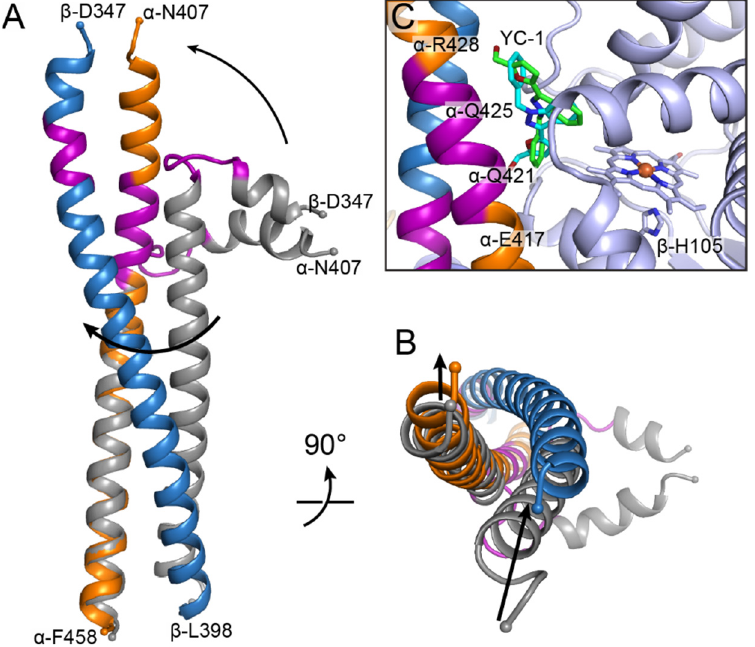
Figure 8. The CC domains play an important role in signal transduction within sGC. ( A ) Super- position of the CC domains in the unactivated (grey, PDB ID 6JT0 [65]) and activated (colored as in Figure 4, PDB ID 6JT2 [65]) states. The CC helices straighten upon activation concomitant with rotation of one helix relative to the other, as indicated by black arrows. Structures were aligned by least squares fitting of residues α 429– α 456 (r.m.s.d. = 1.11 Å for 28 C α atoms). The N- and C-terminal residues of each domain are labeled and shown as small spheres. ( B ) View up the length of the CC domains from the C-terminal end. Rotation of the helices leads to a shifting of the C-terminal residues, as indicated by black arrows. ( C ) Electron density corresponding to YC-1 was observed between the β H-NOX and α CC domains. The two conformations of YC-1 that fit the density are shown in sticks with C in green and cyan, N in blue, and O in red. Residue numbers correspond to the human sGC sequence. β -His105 has been shown in sticks and labeled as a reference point for the α F